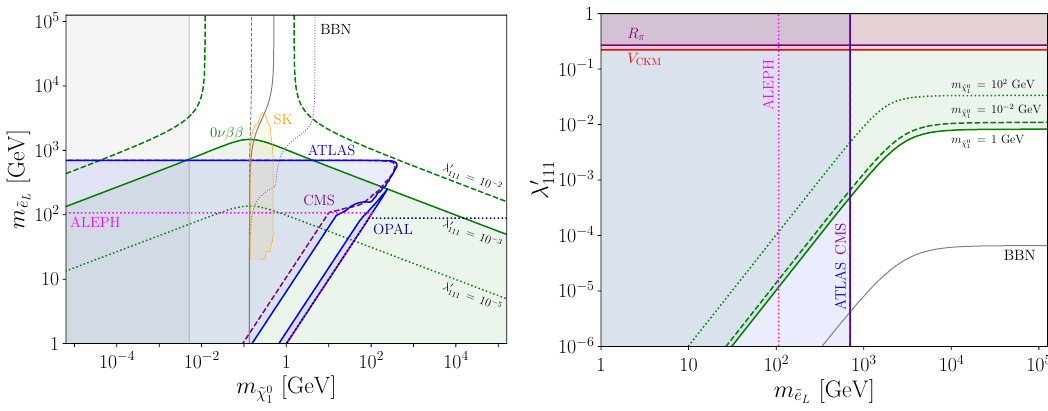
Figure 7 . Excluded regions in the ( m ˜ e , m ) plane (left) and ( λ 0 , m ˜ e ) plane (right). The green ˜ χ 0 1 111 L L regions are excluded by 0 νββ decay ( 76 Ge) for three different values of λ 0 and m respectively. ˜ χ 0 1 111 The blue, dashed purple, magenta and dark blue regions are excluded by collider constraints. The solid red and purple regions are excluded by measurements of V ud and R π respectively, while the orange region is excluded by the non-observation of ˜ χ 0 decays in Super-Kamiokande, with 1 λ 0 = λ 0 = 10 − 3 and m ˜ u = m ˜ = 1900 GeV. The regions to the left and below the grey lines 111 112 d R L are excluded by BBN,